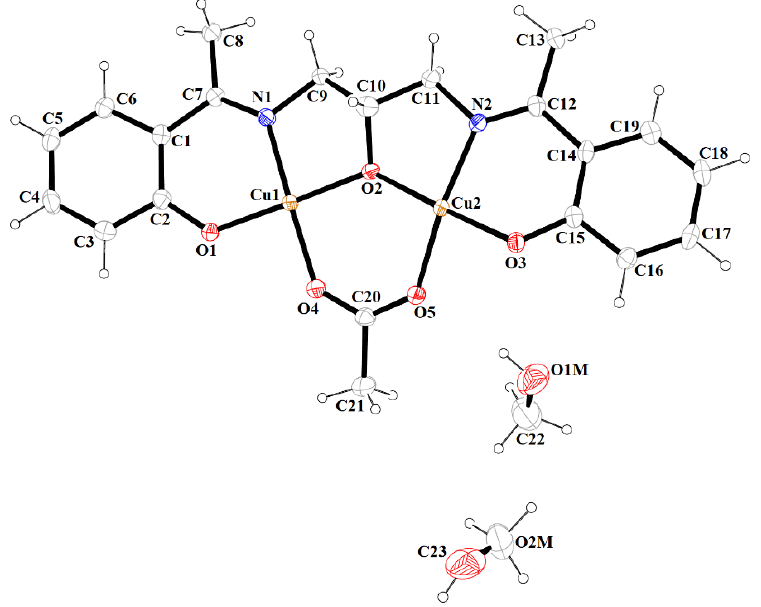
Figure 7. A view of asymmetric unit of 3, showing the atom-numbering scheme. Displacement ellipsoids are drawn at the 60% probability level.